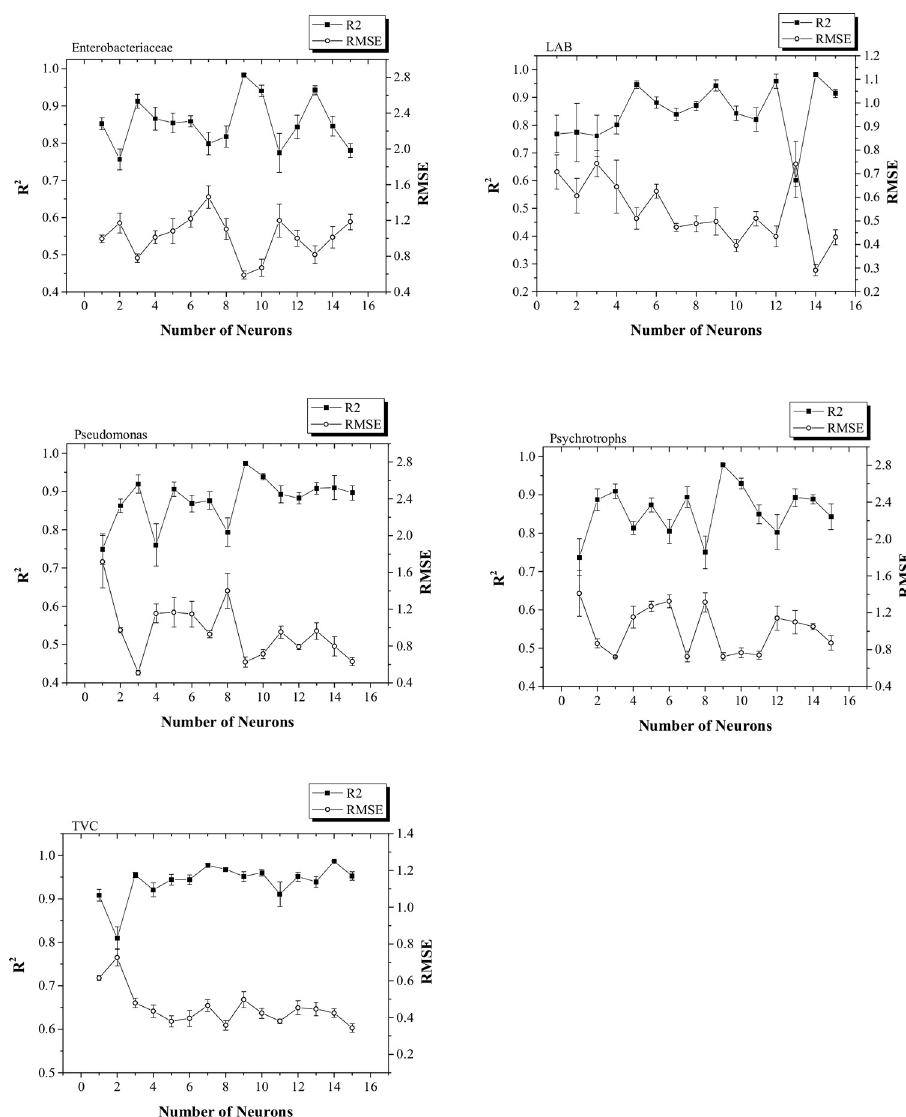
Fig 4. Average and standard error results of R2 and RMSE for five software runs in the procedure of finding the best number of neurons in the hidden layer of feedforward backpropagation ANNs.